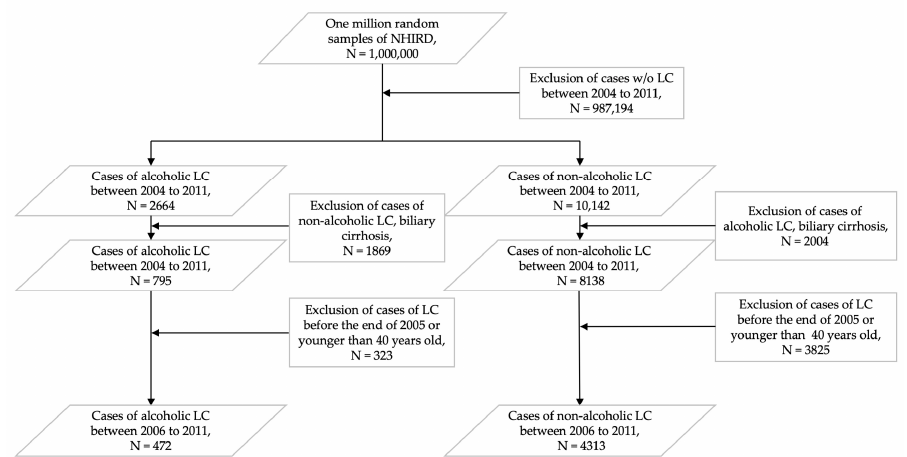
Figure 1. Flowchart of enrollment of alcoholic liver cirrhosis (LC) and non-alcoholic LC in the study cohort. Abbreviations: LC: liver cirrhosis; NHIRD: National Health Insurance Research Database; w / o: without. A total of 323 patients, including patients with LC diagnosed before 2005 (N = 270) and aged < 40 years (N = 53), were excluded from the alcoholic LC cohort between 2004 to 2011. In the non-alcoholic LC cohort between 2004 to 2011, 3825 patients, including patients with LC diagnosed before 2005 (N = 3608) and aged < 40 years (N = 217), were excluded.